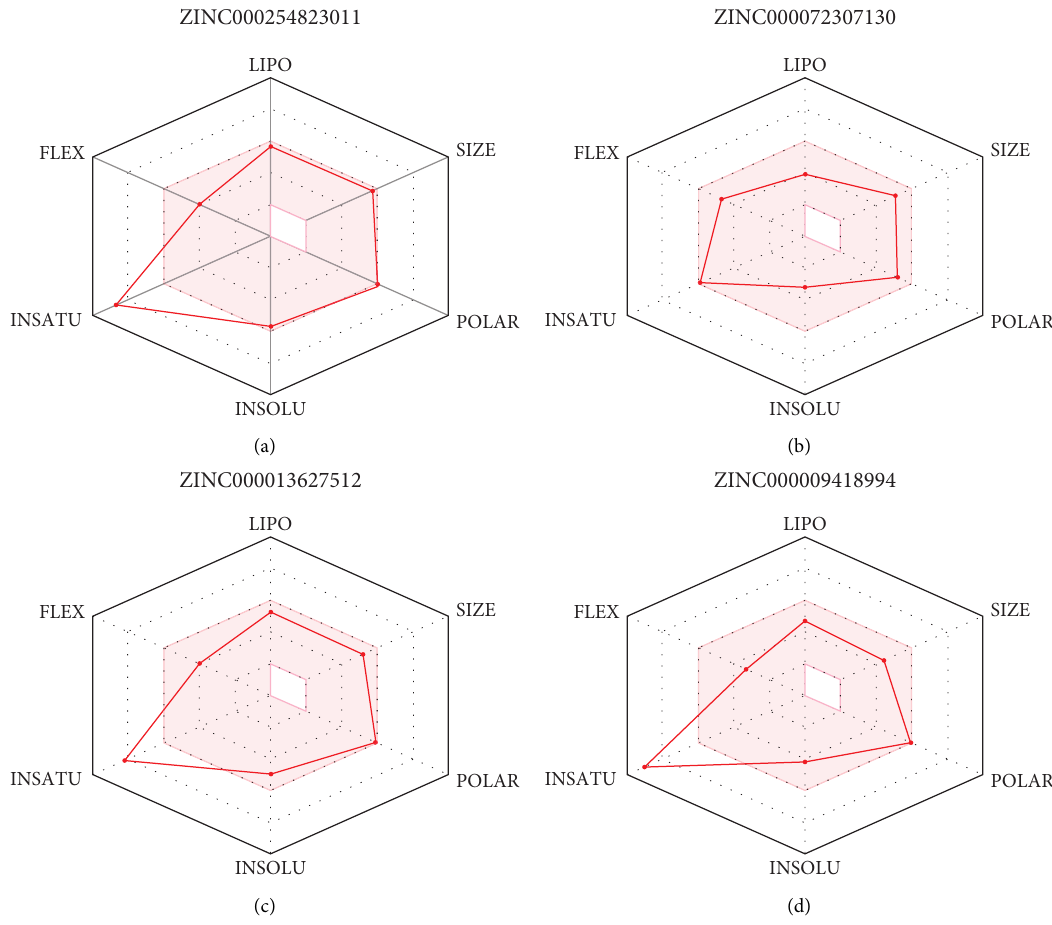
Figure 7: 2D and 3D interaction diagrams showing the binding sites residues. (A) 3D structure of the four drug candidates showing their binding interaction with the target protein (SARS-CoV-2 Mpro. (B) 3D structure displaying the four drug candidates within the binding pocket of the target